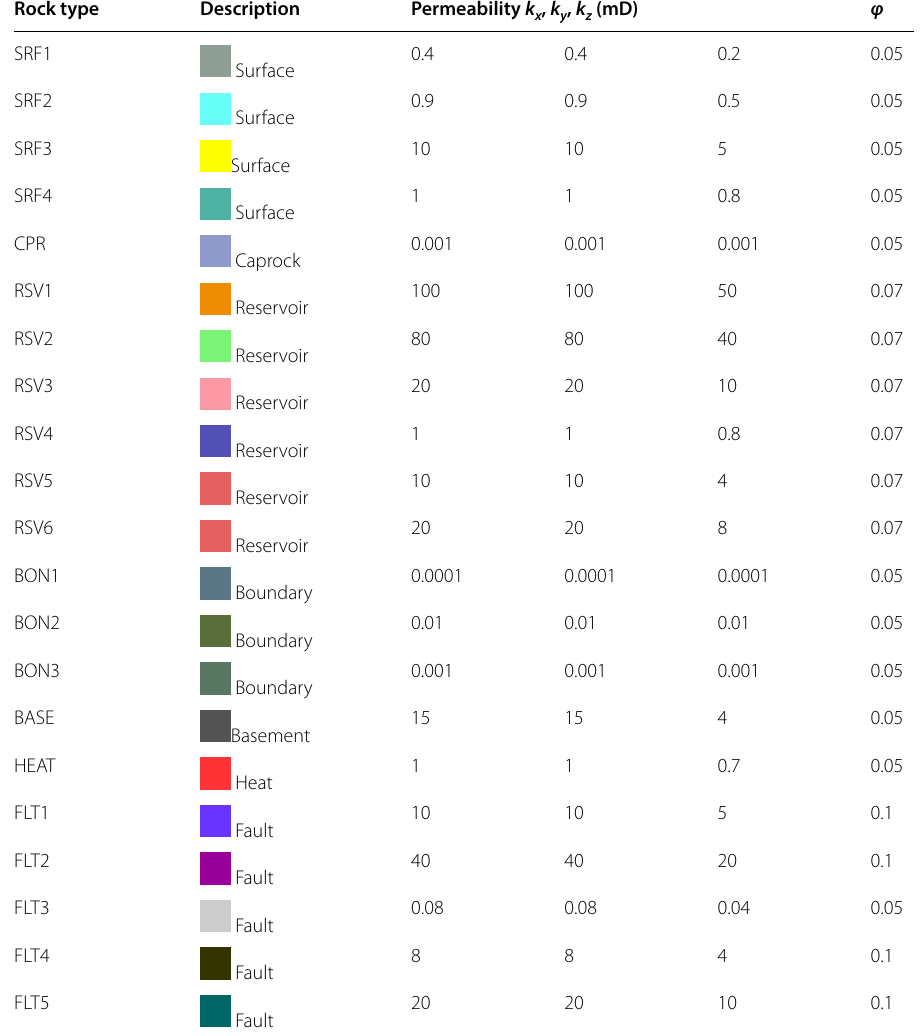
Table 3 The type and physical properties of rocks used to build a reservoir simulation model of the K–TB geothermal